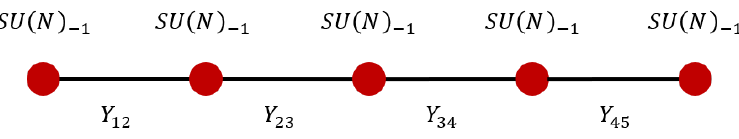
Figure 1 . Parent Chern-Simons matter theory at the phase transition for the special case n = 5. Nodes represent gauge theories with the associated Chern-Simons term and links represent matter bifundamentally charged under the gauge groups on the adjascent